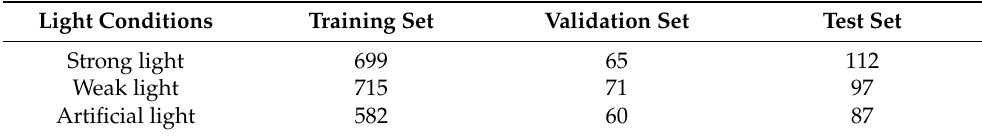
Table 1. Datasets constructed under different lighting conditions.